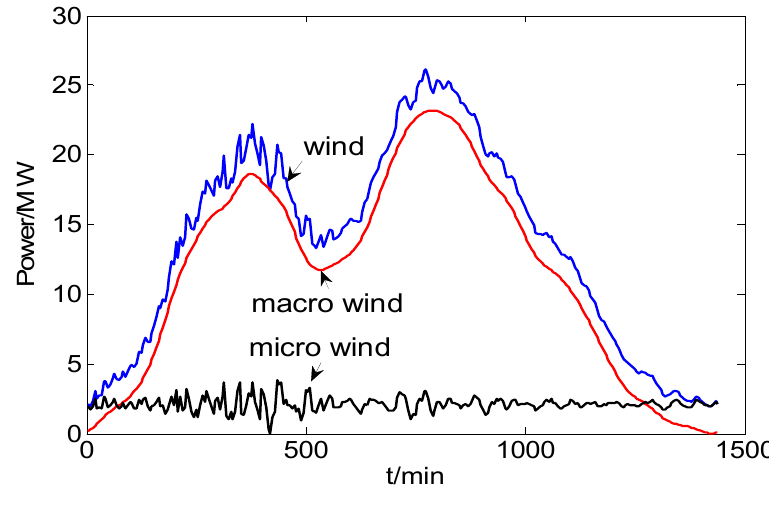
Figure 1. Decomposition of wind power